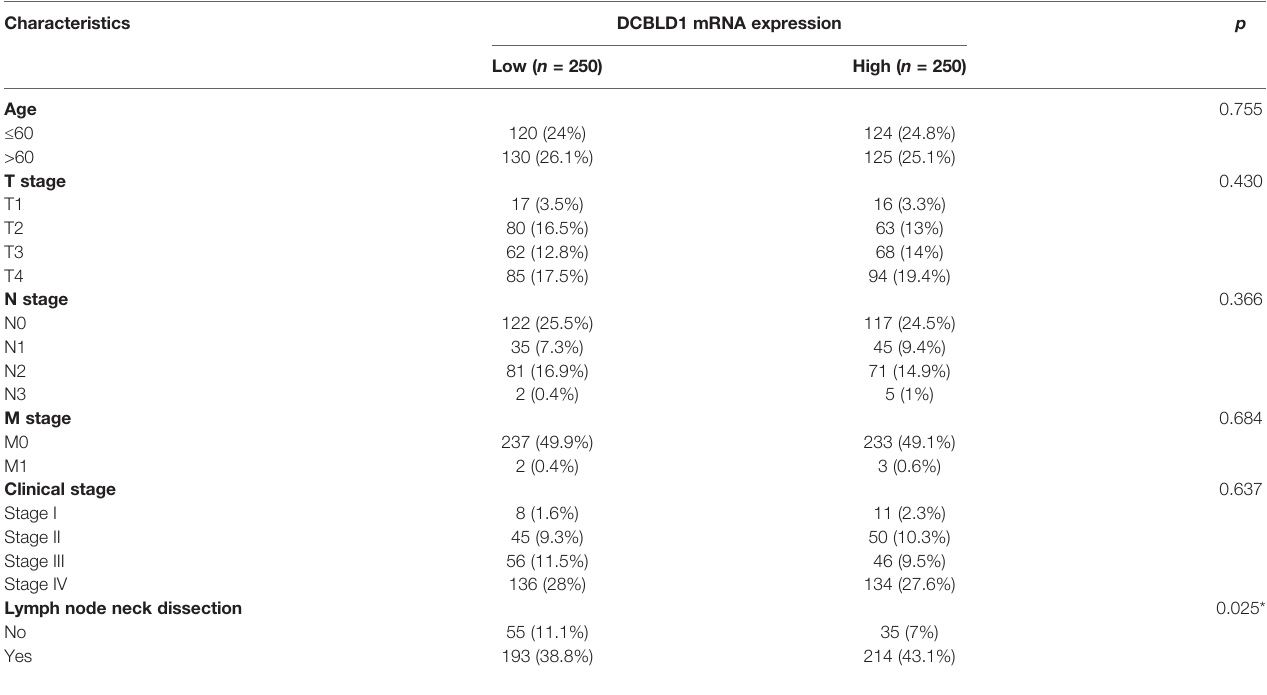
TABLE 1 | DCBLD1 expression in HNSCC patients with different clinical parameters.